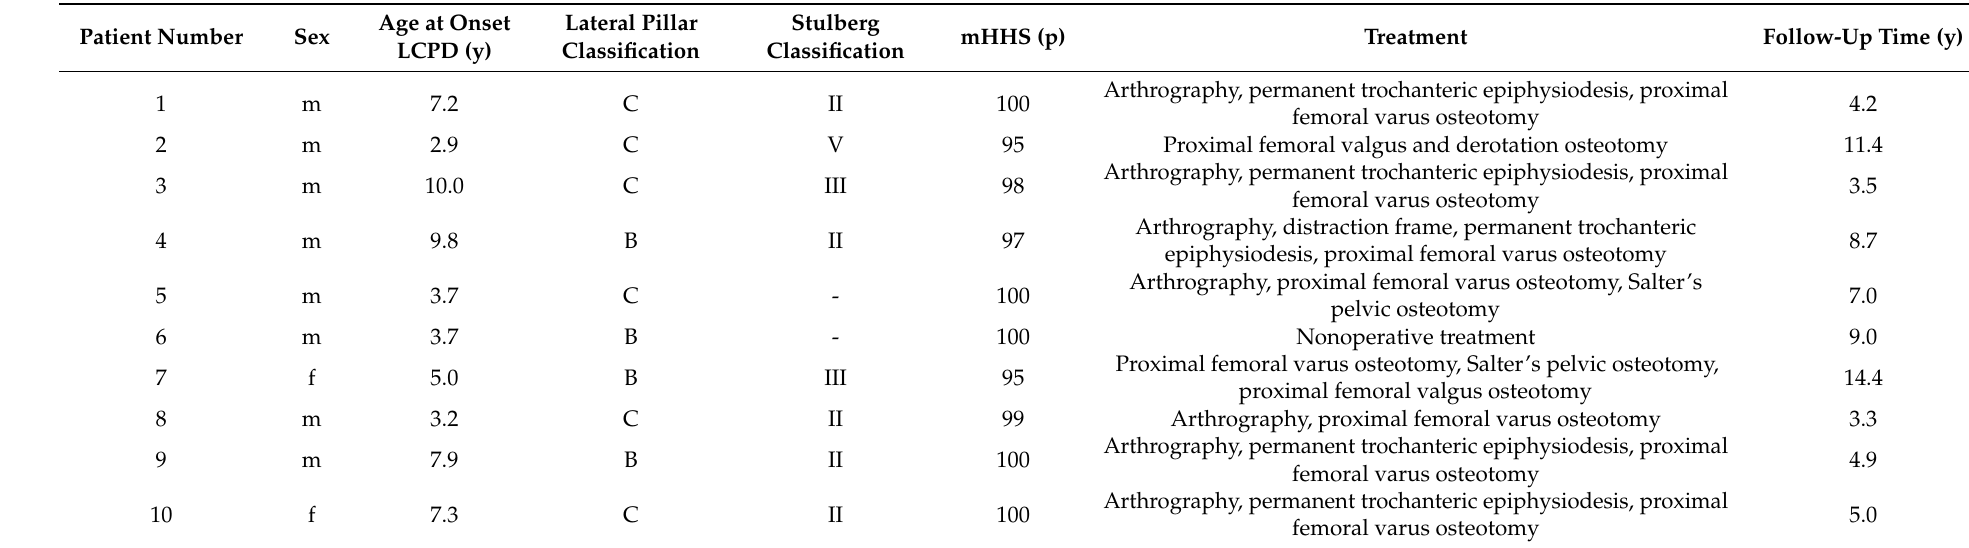
Table 2. Patients with LCPD only (control